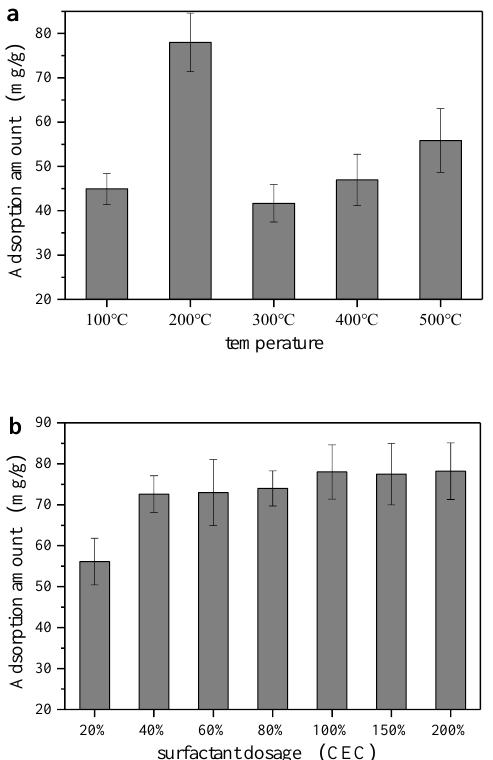
Figure 1. E ff ect of temperature of heat process ( a ) and CTAB concentration ( b ) on the sepiolite modification performance. To evaluate the adsorption amount, 2 g / L modified sepiolite was dosed to 50 mL Acid Orange II solution (200 mg / L) with pH value of 6.5 and then oscillated in a 180 r / min oscillation box for 4 h under constant temperature (25 ◦ C). In ( a ), the 100% CEC CTAB-modified sepiolite was utilized; In ( b ), the modified sepiolite after 200 ◦ C heat modification process was utilized.